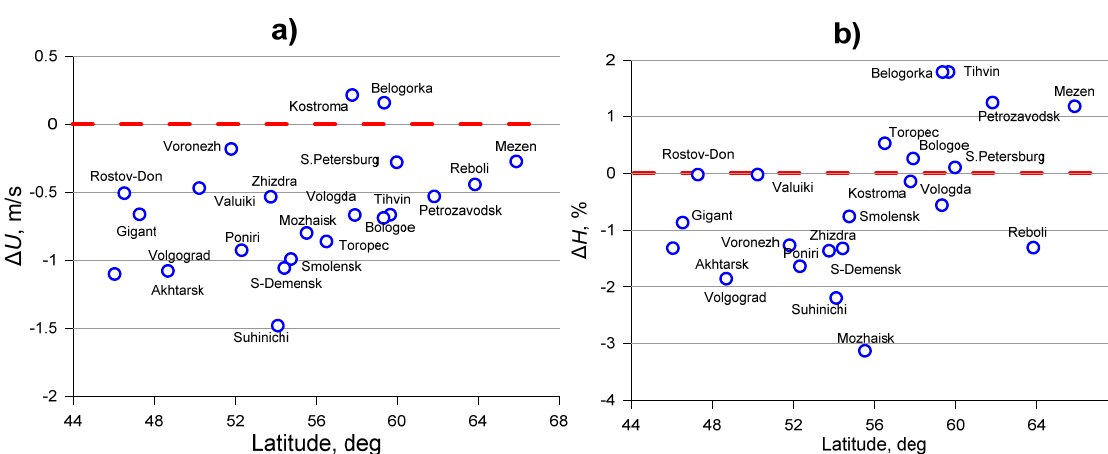
Figure 7. Latitudinal changes in long-term average annual wind speed ∆ U ( a ) and air humidity ∆ H ( b ) in modern period.